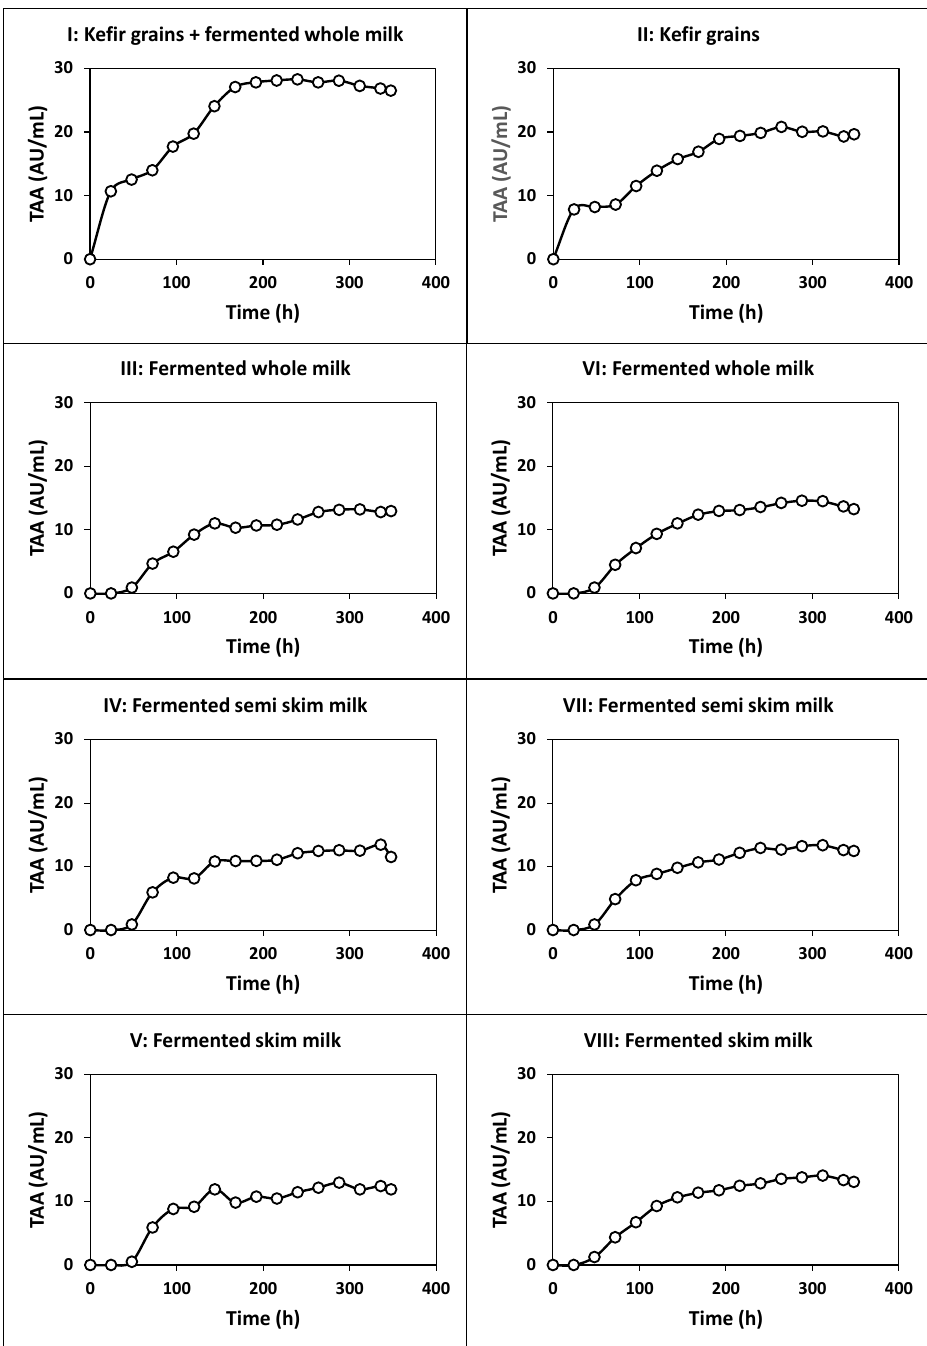
Figure 5. Kinetics of total antibacterial activity (TAA) production in the different fed-batch fermen- tations in deproteinized whey. In fermentations III, IV and V, the culture medium was inoculated with milk fermented with kefir grains with agitation at 150 rpm. In fermentations VI, VII and VIII, the culture medium was inoculated with milk fermented with kefir grains under static conditions.